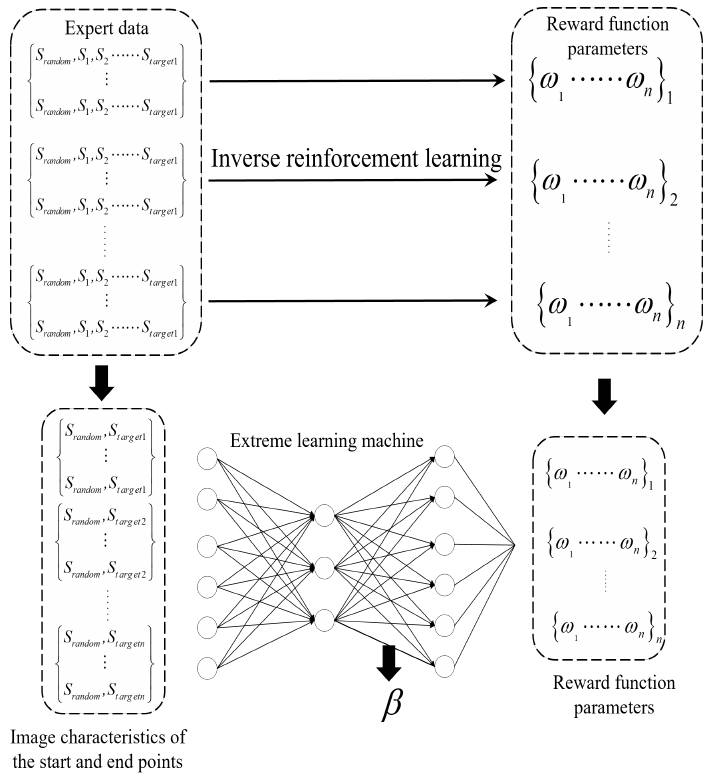
Figure 3. Structure diagram of extreme learning machine combined with expert